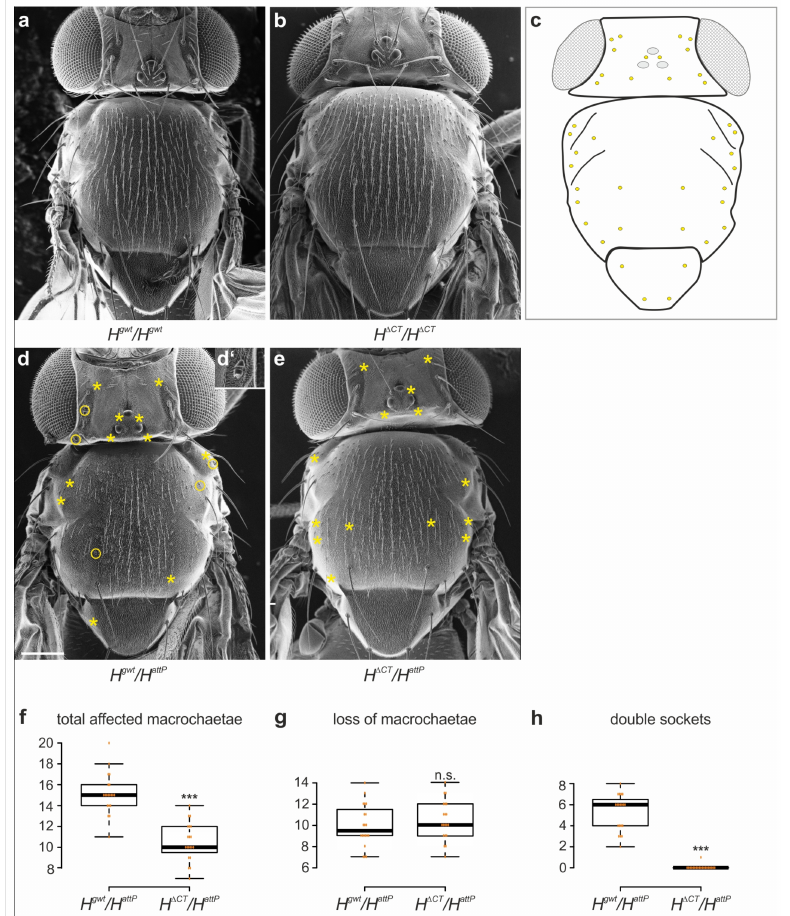
Figure 4. Macrochaetae formation in hemizygotes. ( a , b ) Scanning electron micrographs from homozy- gous controls H gwt / H gwt ( a ) and H ∆ CT / H ∆ CT ( b ), respectively. No defects in macrochaetae observed ( n = 14,20). ( c ) Schematic drawing showing the 40 defined positions of macrochaetae in the wild type [86]. ( d , e ) Typical examples of hemizygous female flies H gwt / H attP ( d , d‘ ) and H ∆ CT / H attP ( e ). Asterisks mark the absence, circles a shaft to socket transformation (example of a resultant double socket is shown enlarged in ( d‘ )). Scale bar, 200 µ m in ( a , b , d , e ). ( f – h ) Quantification of macrochaetae misdevelopment ( n = 20) as indicated. Box blot limits indicate 25th and 75th percentiles; whiskers extend 1.5 times the interquartile range; center lines show the medians (assembled by BoxPlotR). All values are indicated with orange dots, including outliers. Significance was determined with Student’s t -test (*** p ≤